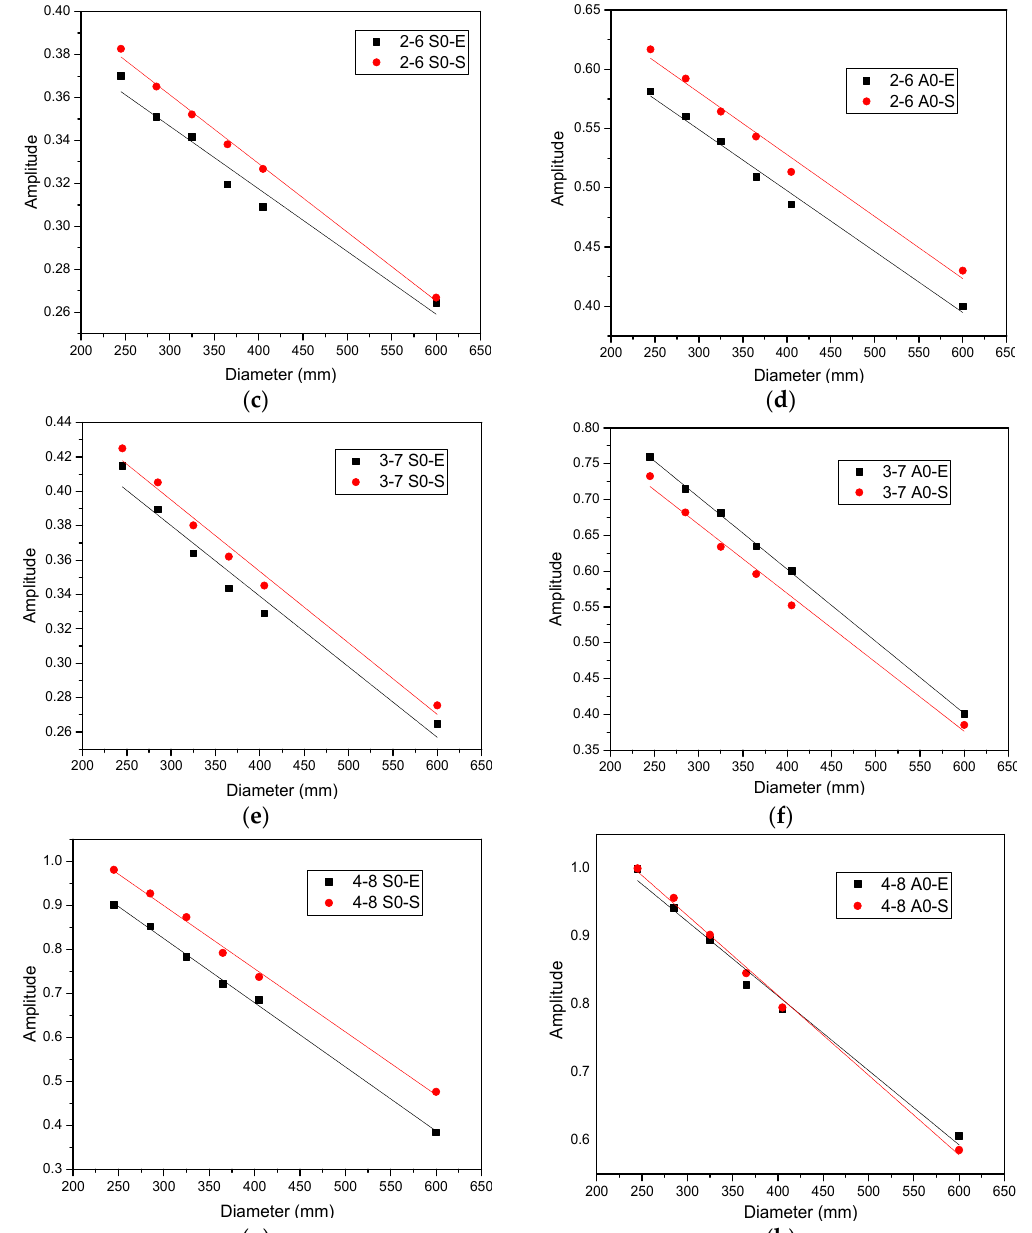
Figure 12. Amplitude of A0 and S0 varies with radius. ( a ) S0 mode in the 1–5 orientation, ( b ) A0 mode in the 1–5 orientation, ( c ) S0 mode in the 2–6 orientation, ( d ) A0 mode in the 2–6 orientation, ( e ) S0 mode in the 3–7 orientation, ( f ) A0 mode in the 3–7 orientation, ( g ) S0 mode in the 4–8 orientation, and ( h ) A0 mode in the 4–8